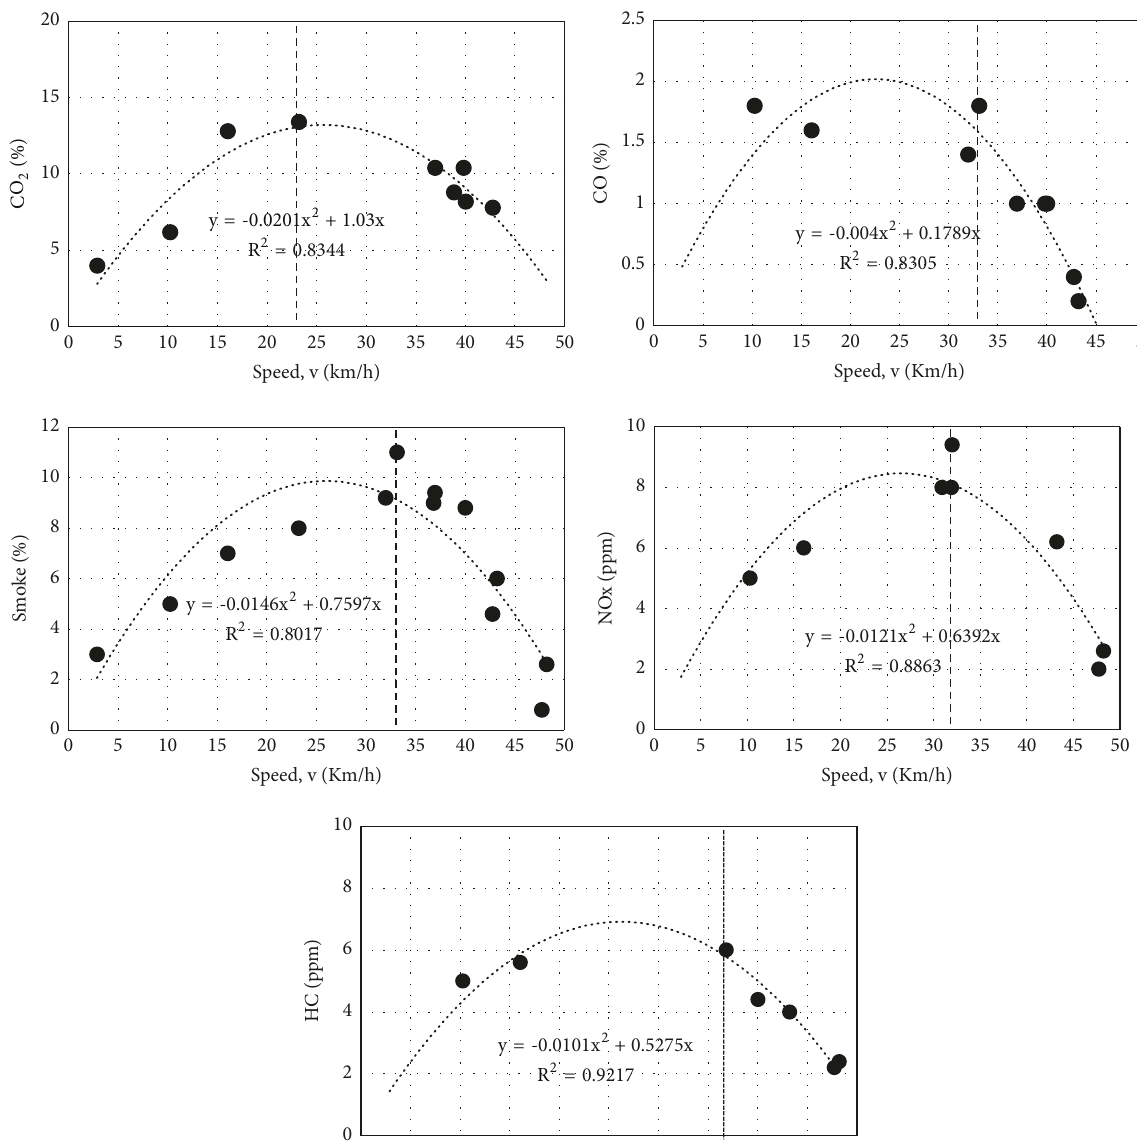
Figure 5: Exhaust emission driving cycle pattern on good road